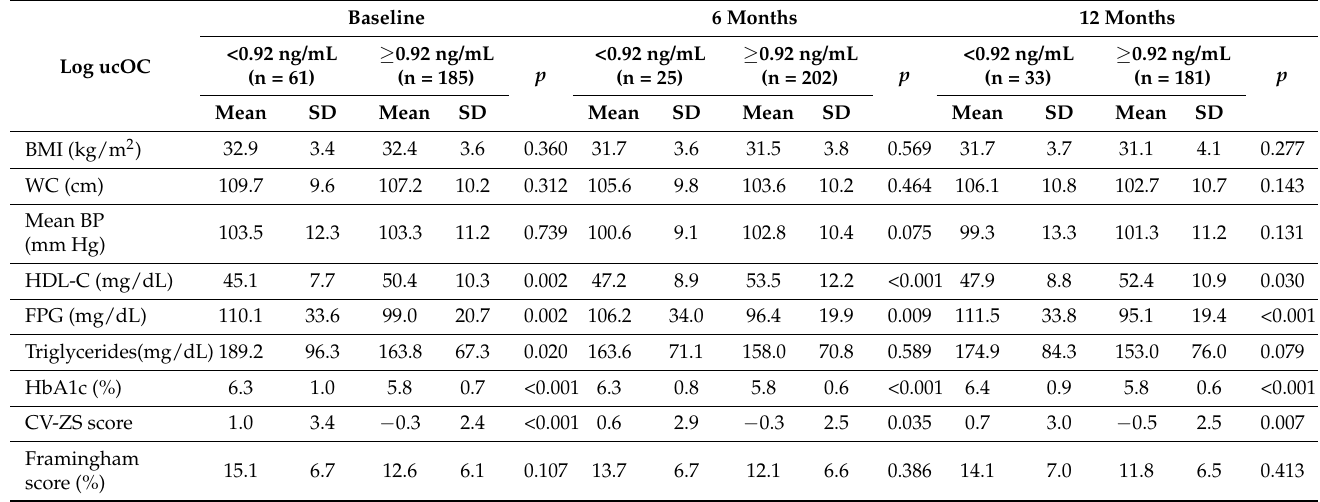
Table 6. MetS and T2D factors according to the 25th percentile of baseline serum levels of ucOC (log) in the total sample of MetS